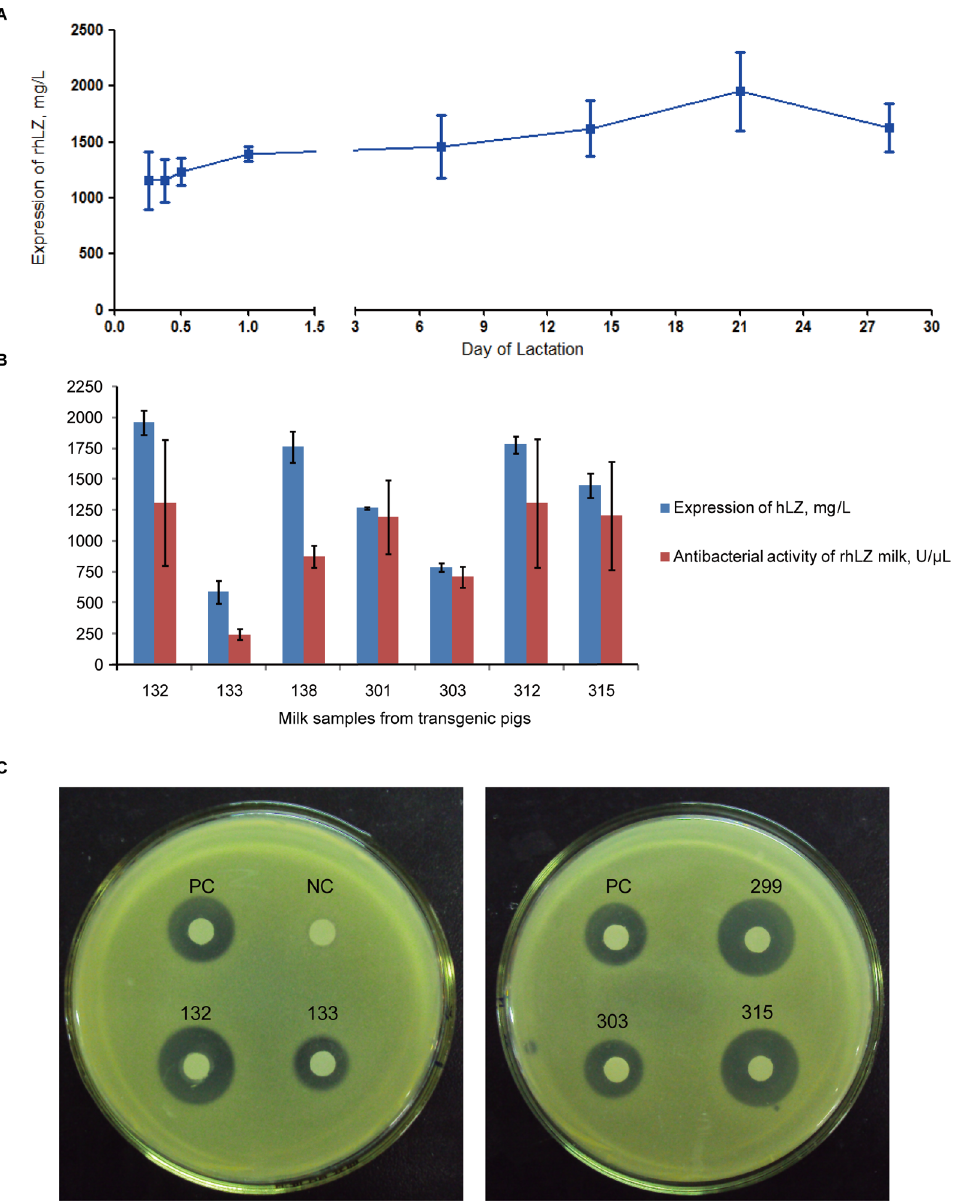
Fig 3. rhLZ concentration and enzymatic activity in transgenic milk. A)hLZ expression levels of transgenic sows during the lactation period. Values are means ± standard deviations. B)Expression level and antibacterial activity of rhLZ on day 7 in transgenic milk. Values are means ± standard deviations. C) The gel diffusion assay. Dilution milk samples (dilution, 1:3, 6 μ L) were added to 6-mm small white quantitative filters. PC, commercial natural hLZ standard (1 μ g); NC, milk from WT pig.